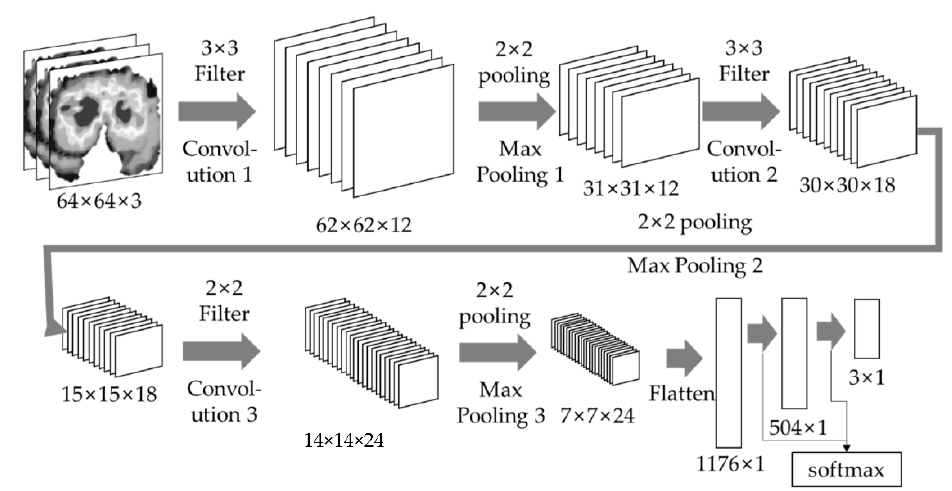
Figure 6. The structure of the PRS. Algorithm 1. Information stored in PST